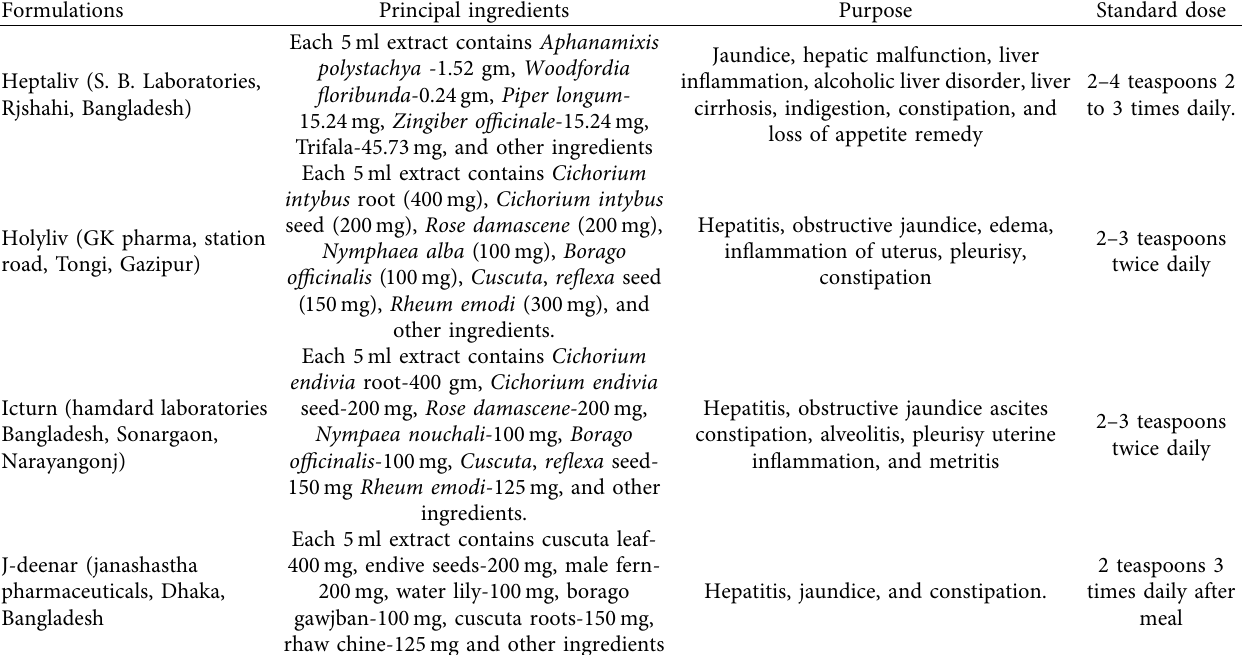
Table 1: The four marketed polyherbal formulations (liquid) used in current study of activities against liver injury (compiled from the manufacturer’s